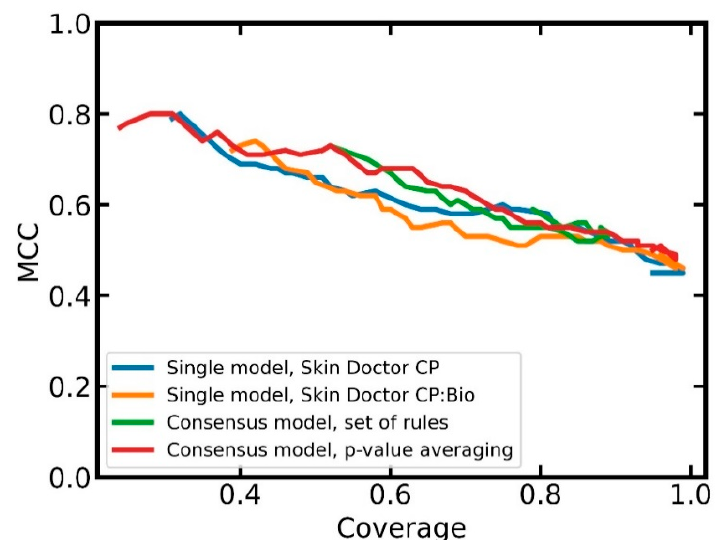
Figure 6. Relationship between MCC and coverage for the individual and the combined models.